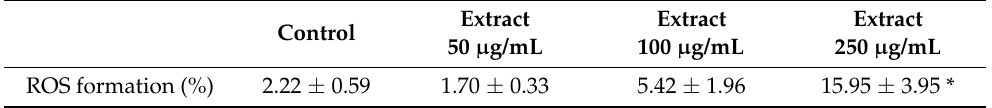
leaf extract. Table 6. Percentage of ROS formation of A549 cells treated with various concentrations of C. chinense